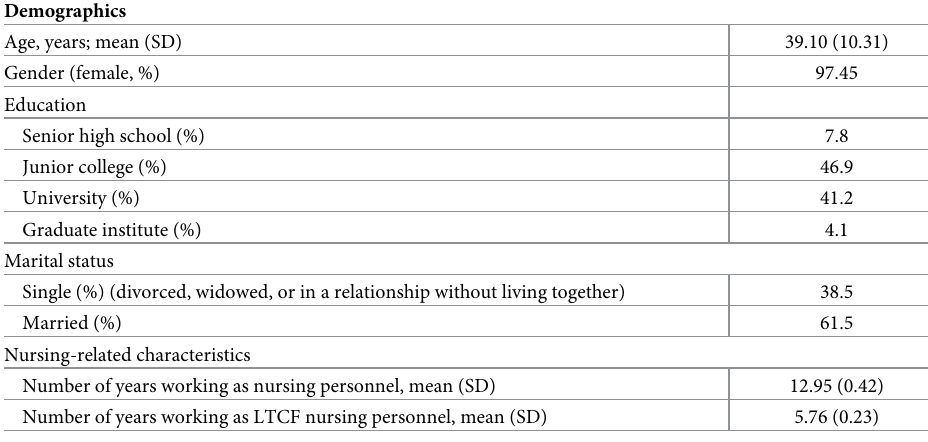
Table 1. Demographic and nursing characteristics ( N =